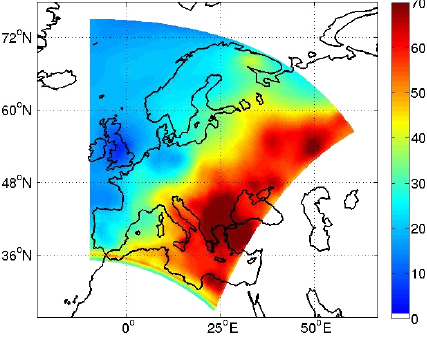
Figure 17. Annual mean aerosol radiative forcing at the TOA (Wm − 2